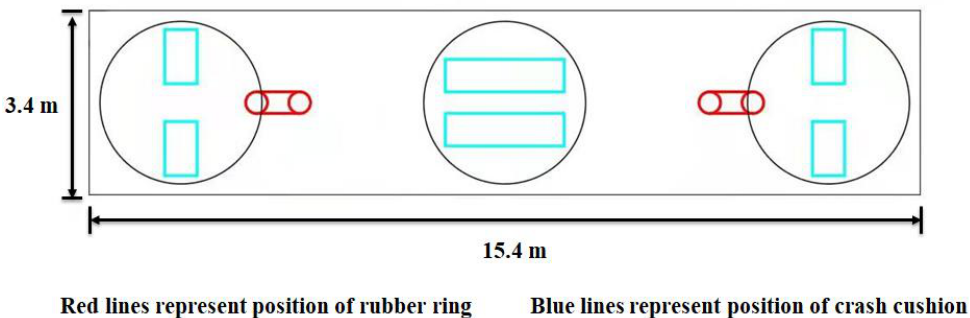
Figure 4. Schematic diagram of connecting structure at the other end of adjacent floating breakwa- ter modules.